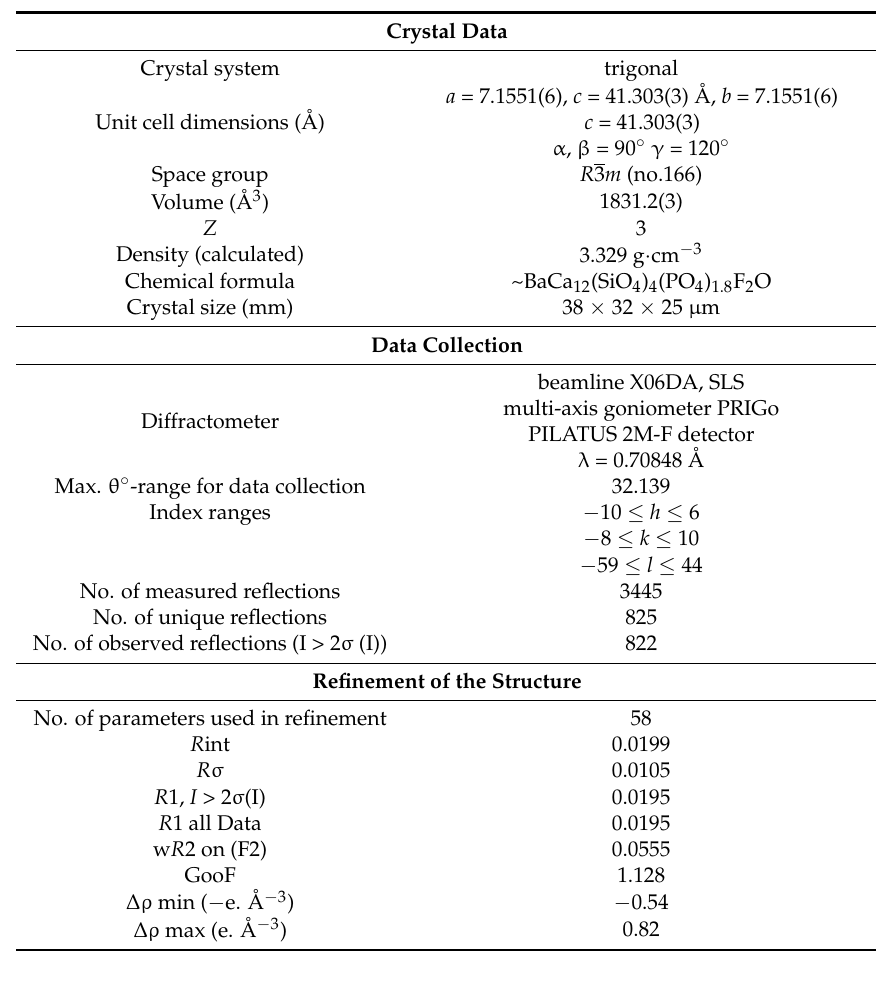
Table 2. Parameters for X-ray data